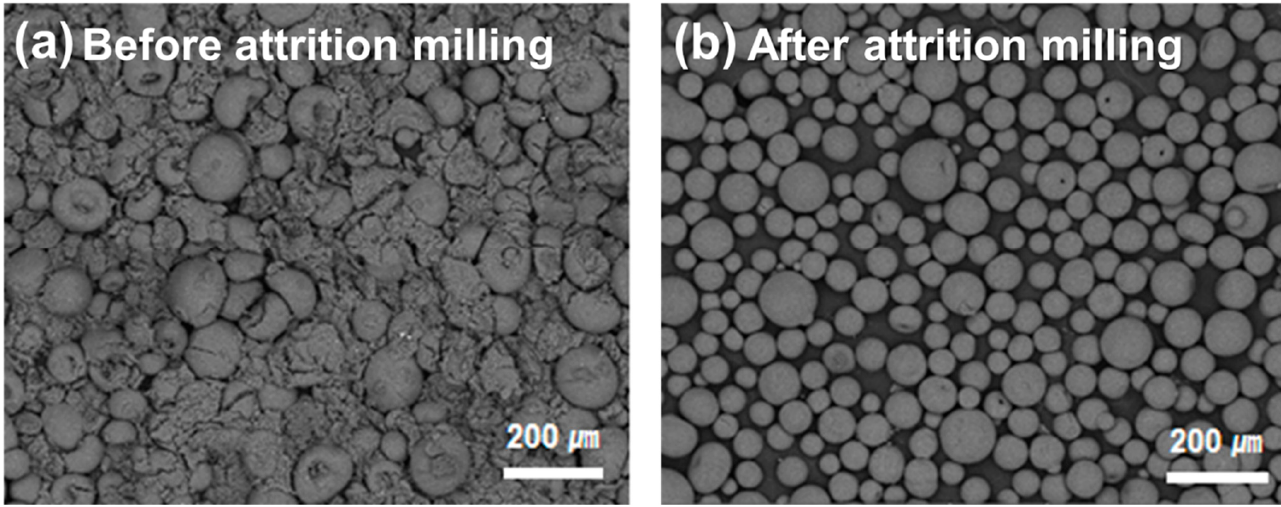
Figure 3. SEM images of the mullite–cordierite composite granules: ( a ) before and ( b ) after attrition milling.